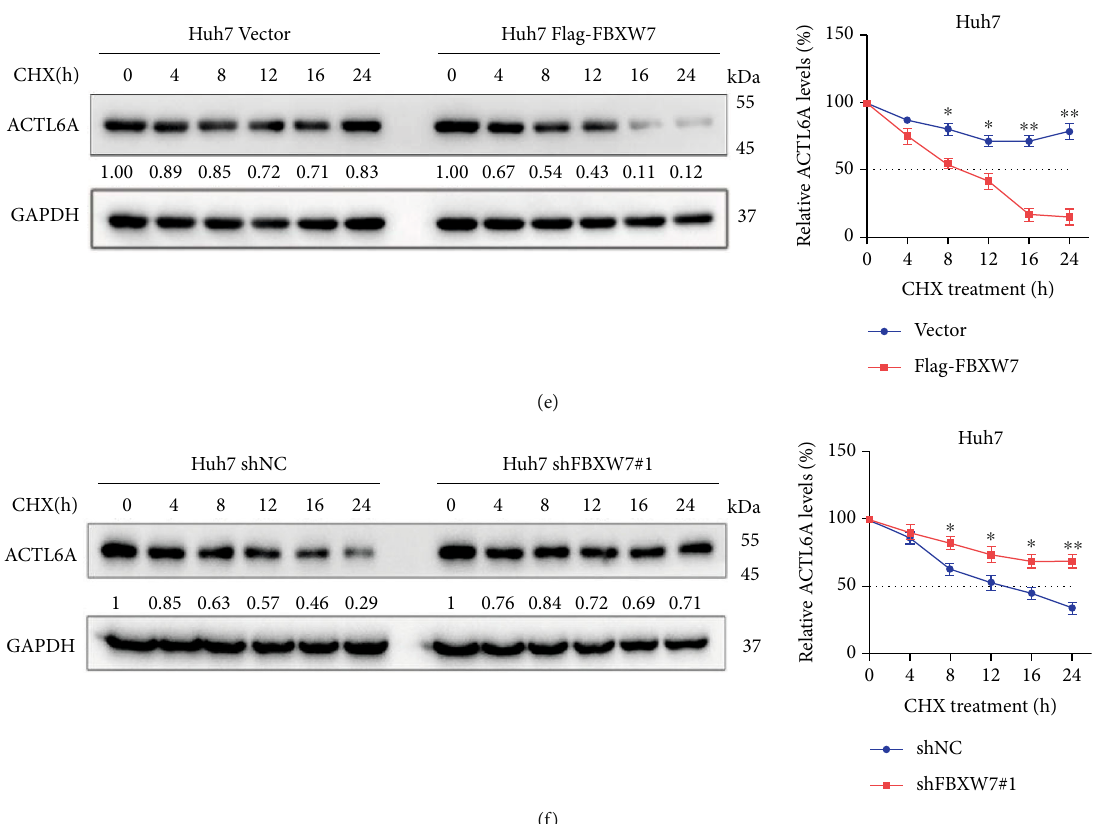
Figure 5: FBXW7 negatively regulates ACTL6A stability via the ubiquitin-proteasome pathway. (a) RT-qPCR analysis of ACTL6A transcript level in MHCC-97H and Huh7 cells. (b) The above cells were incubated with MG132 (10 μ M) for 12 h, and total protein was extracted and subjected to Western blot. (c – f) MHCC-97H and Huh7 cells were treated with CHX (50 μ g/mL), harvested, and immunoblotted for ACTL6A and GAPDH. Quanti fi cation of the ACTL6A protein levels relative to GAPDH expression. Graph represents mean ± SD ; ∗ P < 0 : 05 , ∗∗ P < 0 : 01